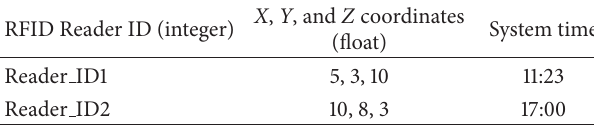
Table 5: Output table of the Localization Service.